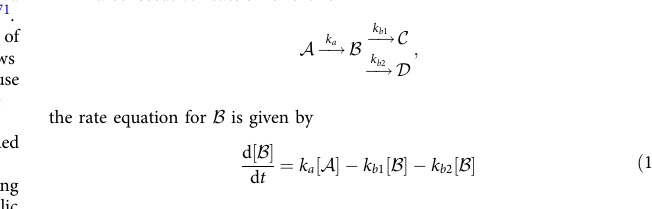
. An asterisk indicates the species that are in an excited 10